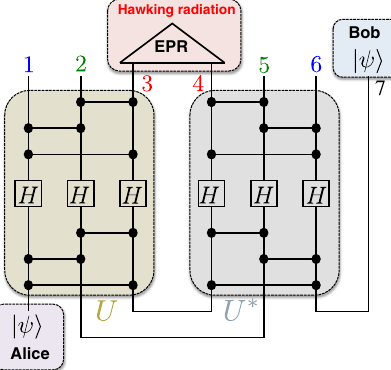
FIG. 4. Decoding circuit based upon a 3-qubit Clifford scram- bler. Alice ’ s quantum state j ψ i is supported on qubit 1, while Bob ’ s quantum register corresponds to qubit 7. The left (beige) and right (gray) Hilbert spaces have the following correspond- ences 1 ↔ 6 , 2 ↔ 5 , and 3 ↔ 4 (with respect to U ⊗ U (cid:3) ). By performing an EPR projection on qubits 3 and 4, Bob teleports Alice ’ s quantum state to his register qubit. In the case of this Clifford scrambler, Bob could also have achieved teleportation by performing EPR projections on either qubits f 1 ; 6 g or f 2 ; 5 g . This distinguishes the Clifford scrambler from other more trivial (nonscrambling) unitaries (i.e., a SWAP gate), where teleporta- tion occurs only for EPR projection on a specific pair of